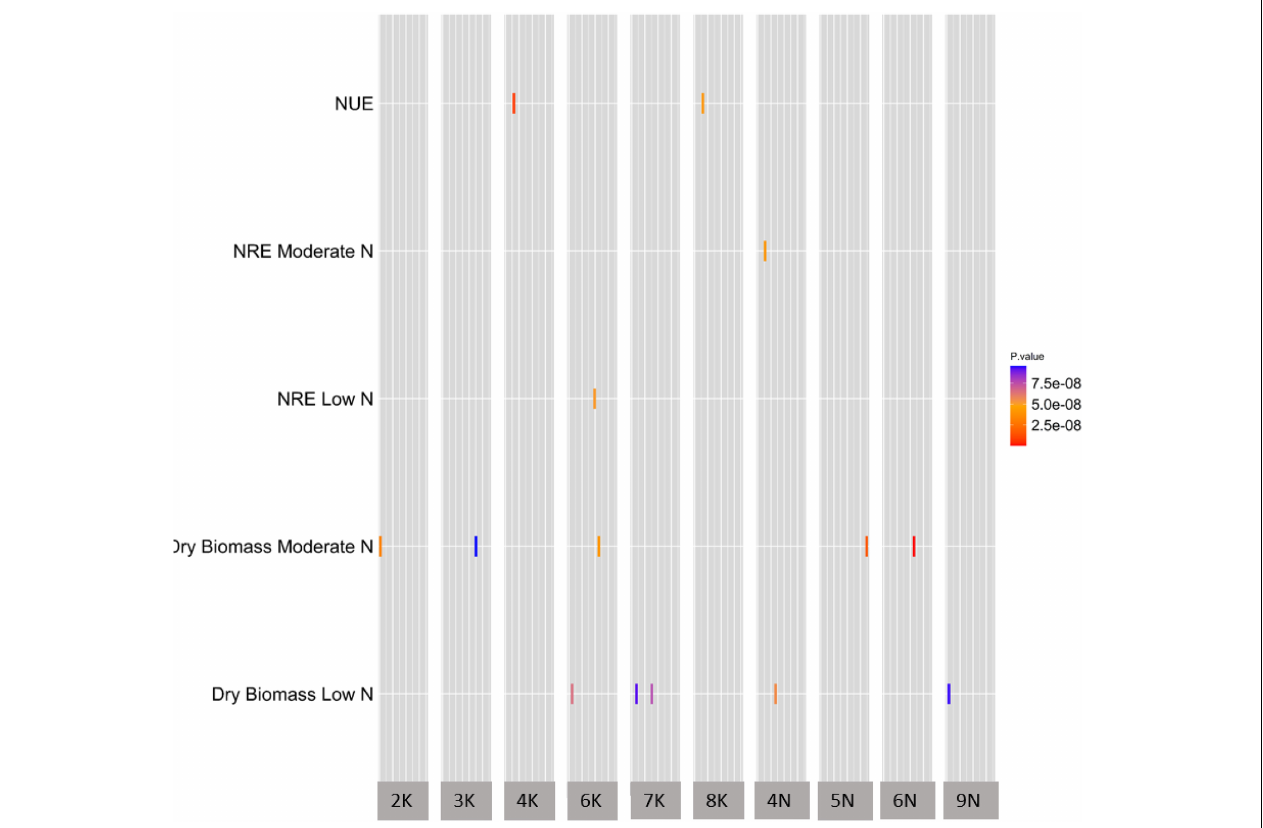
FIGURE 2 | A summary of GWAS of NUE and the related traits. The heatmap of GWAS of NUE and the related traits demonstrating significant SNP distribution across chromosomes. All five traits on y-axis were significant at the genome-wide threshold level of significance at 8.0 × 10 − 8 (1/N, with N = 11,976,628, where N is the total number of SNP markers used in this GWAS study). The x-axis shows the chromosome number for significant SNPs, while the y-axis shows all traits with significant SNP-trait associations. The width of the gray bar of a given chromosome number on the x-axis indicates the chromosomal position of that chromosome. The units of traits in y-axis; NUE (nitrogen use efficiency) is Kg Kg/m 2 ; NRE at moderate and low N is %; dry biomass for low and moderate N is Kg; rectangles represent SNPs that are color coded based on p